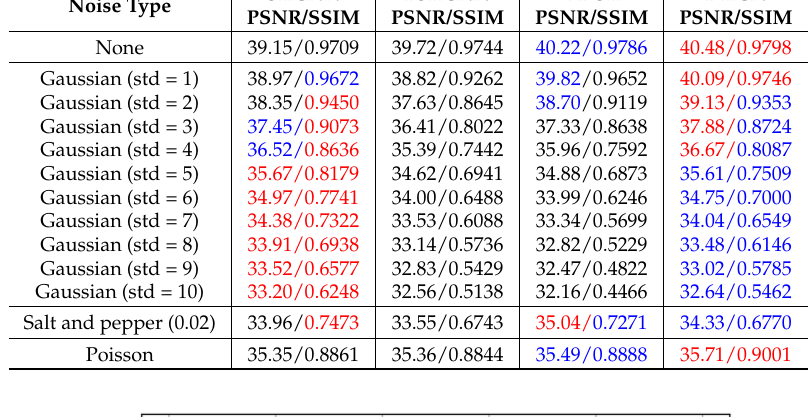
Table 13. The effect of noise on reconstruction results. The red font indicates the best performance, while the blue font indicates the second best.